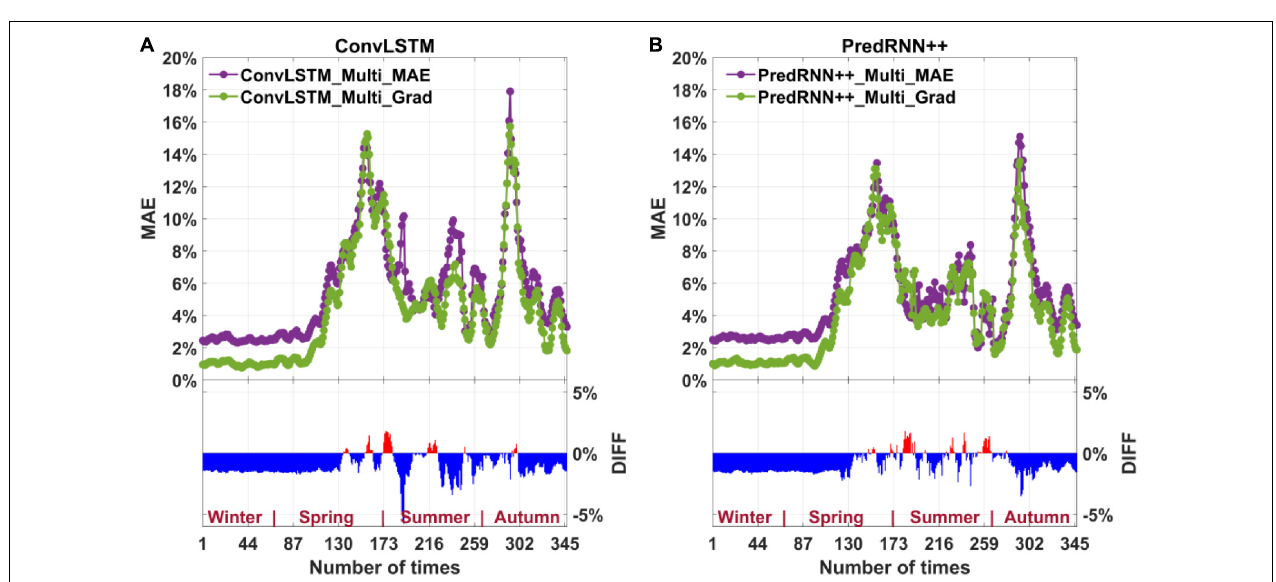
FIGURE 7 | The SSIM for multi-factor prediction of ConvLSTM based on MAE-loss and Grad-loss (A) ; the SSIM for multi-factor prediction of PredRNN++ based on MAE-loss and Grad-loss (B) . The DIFF in the bar graph is obtained by subtracting the model based on MAE-loss from the model based on Grad-loss.